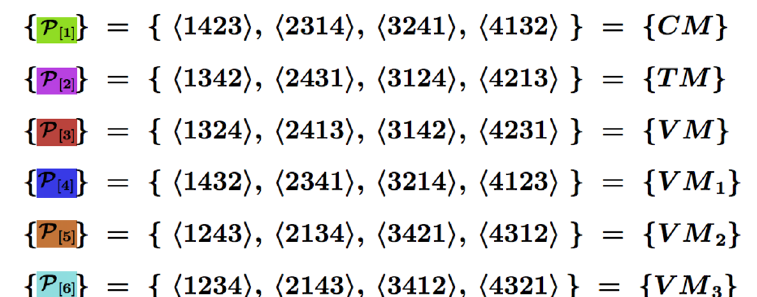
Figure 2 . A dissection of BC 4 in lexicographical ordering using “ hi 00 basis elements.